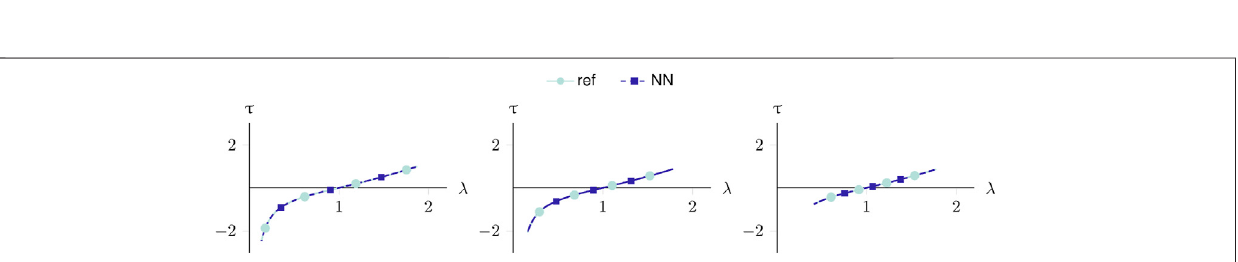
FIGURE7| Trainingandvalidationlossduringhyperelasticconstitutivemodeltraining.Bothlossesrapidlyreducewithinthe fi rst20epochsbeforeoscillatingdueto variance shift combined with the singular behavior of the stretch near the origin.